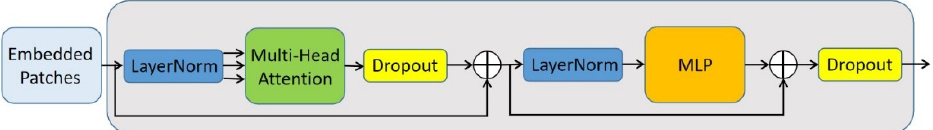
Figure 5. The architecture of a transformer encoder block, which contains two main sub-blocks. The first sub-block is a multi-head attention block and the second one (MLP) is a fully connected layer. Residual connections are used between each sub-block. Multi-head attention can help the current node to not only pay attention to the current pixels, but also obtain the semantics of the context. The primary role of Spatial Pyramid Pooling (SPP) [23] is to solve the problem of the non-uniform size of the input images, and the fusion of different size features in SPP is beneficial in the case of large differences in object size in the detected images. TPH-YOLOv5 only uses the SPP block at the bottom of the backbone, and we add 4 SPP blocks in the neck of the network, which cause the feature maps to go through multiple multi-scale fusion steps, enriching the expression capability of the feature maps. In our network, SPP is implemented using kernels of uniform stride (stride = 1) but different sizes (5 × 5, 9 × 9 and 13 × 13), and feature fusion is achieved by channel stitching (concat). The architecture of SPP block is shown in Figure 6.